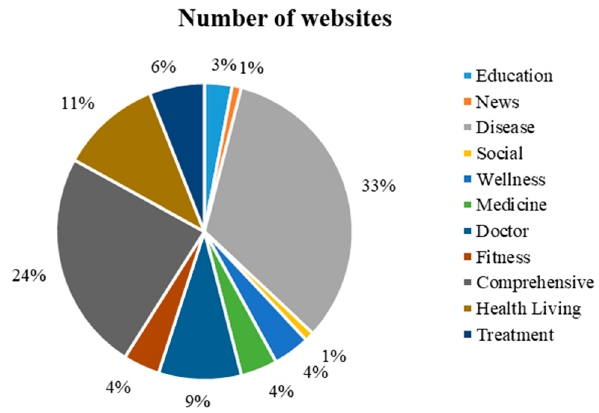
Figure 2. Distribution of topics among 100 health-related websites.